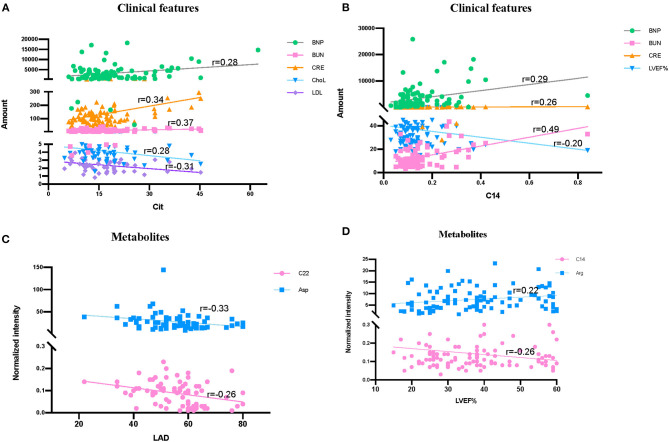
Correlation among clinical features and significantly differentially metabolites in HF patients and control groups. (A) Correlation among Cit, clinical renal function features (BNP, BUN, and CRE) and serum lipids index (ChoL and LDL). (B) Correlation among C14, LVEF% and clinical renal function features (BNP, BUN, and CRE). (C) Correlation among LAD, C22, and Arg. (D) Correlation among LVEF%, C14 and Arg. Data were analyzed by linear regression in figure.